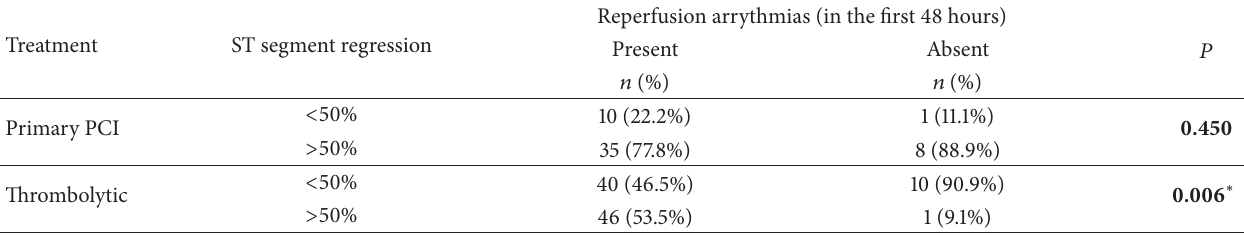
Table 5: Association between the occurrence of reperfusion arrythmias and ST segment regression in primary PCI and thrombolytic treatment groups.